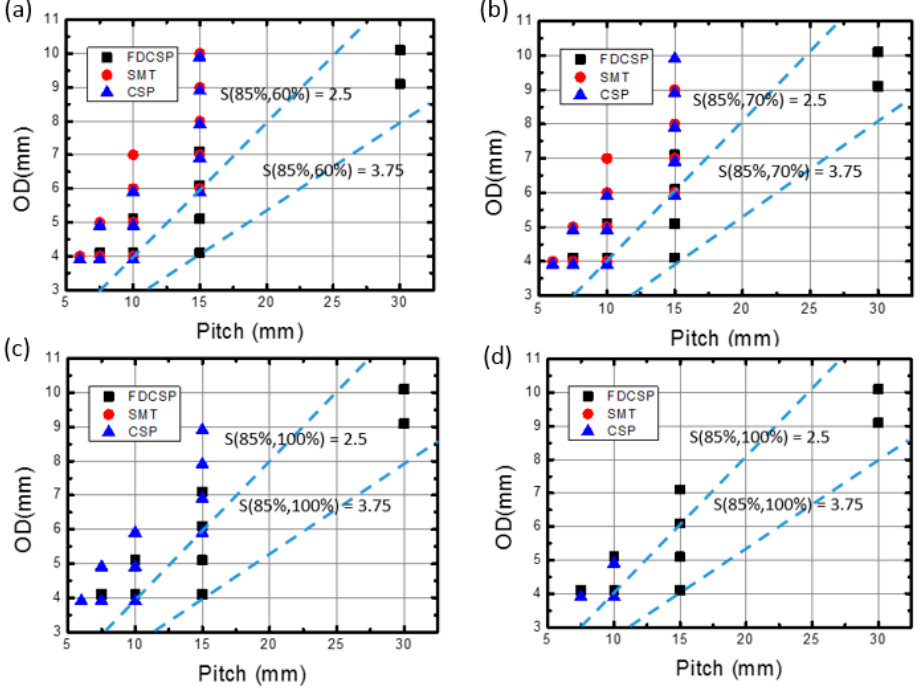
Figure 8. The strategy map for ( a ) uniformity > 85%, Intensity > 60%, ( b ) uniformity > 85%, Intensity > 70%, ( c ) uniformity > 85%, Intensity > 100%, and ( d ) uniformity > 85%, Intensity > 110%.